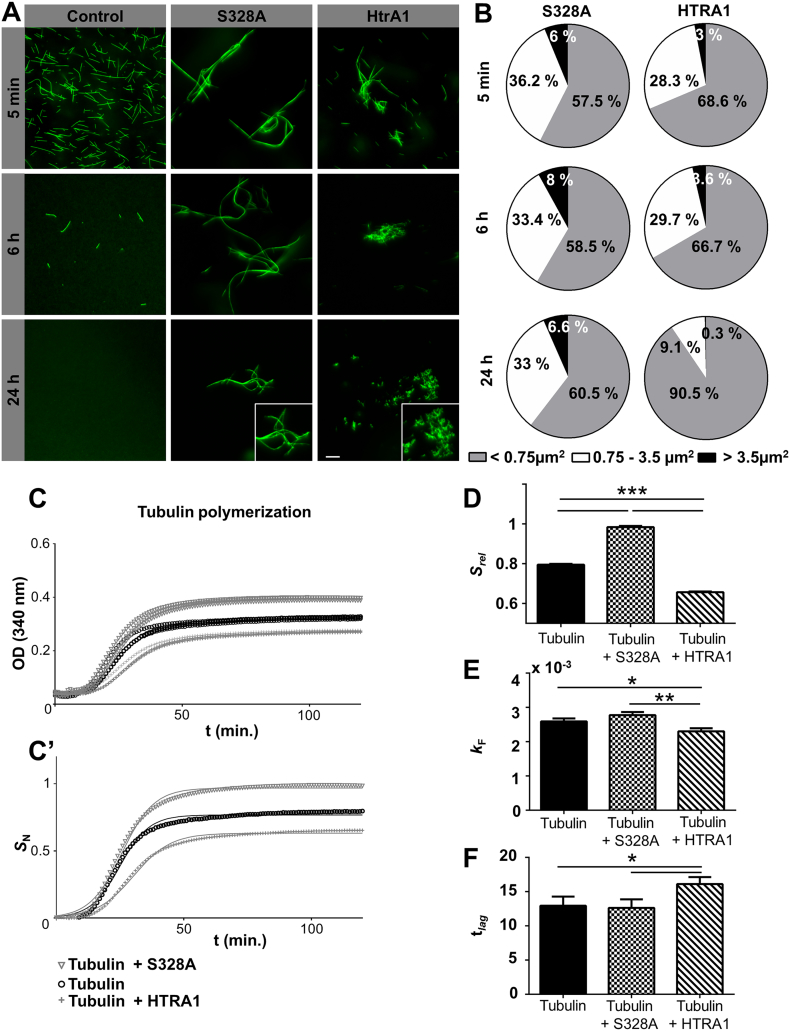
HtrA1 degrades preformed MT and avoids polymerization in vitro. (A) MT polymerized in vitro and incubated with S328A HtrA1 (center) and HtrA1 (right). Images acquired at 5 min, 6 h and 24 h after adding the protease. Scale bar, 10 μm. (B) Quantification of the area occupied by the MT 5 min, 6 h and 24 h after adding the protease. (C) Microtubule polymerization reactions in the absence or presence of S328A HtrA1 and HtrA1. As a representative growth signal, the absorbance at 340 nm was monitored in vitro as a function of time for three independent replicates. (C′) The average growth signal for each variant was calculated and normalized relative to the overall maximum. Best fits to sigmoidal function are shown with solid lines. (D) Comparison of the growth amplitudes (Srel), (E) kinetic rate constants (kF), (F) nucleation time (tlag) of microtubule polymerization reaction in the absence or presence of S328A HtrA1 and HtrA1. Mean ± SD for three replicates are reported, *p < 0.05, **p < 0.01, ***p < 0.001.